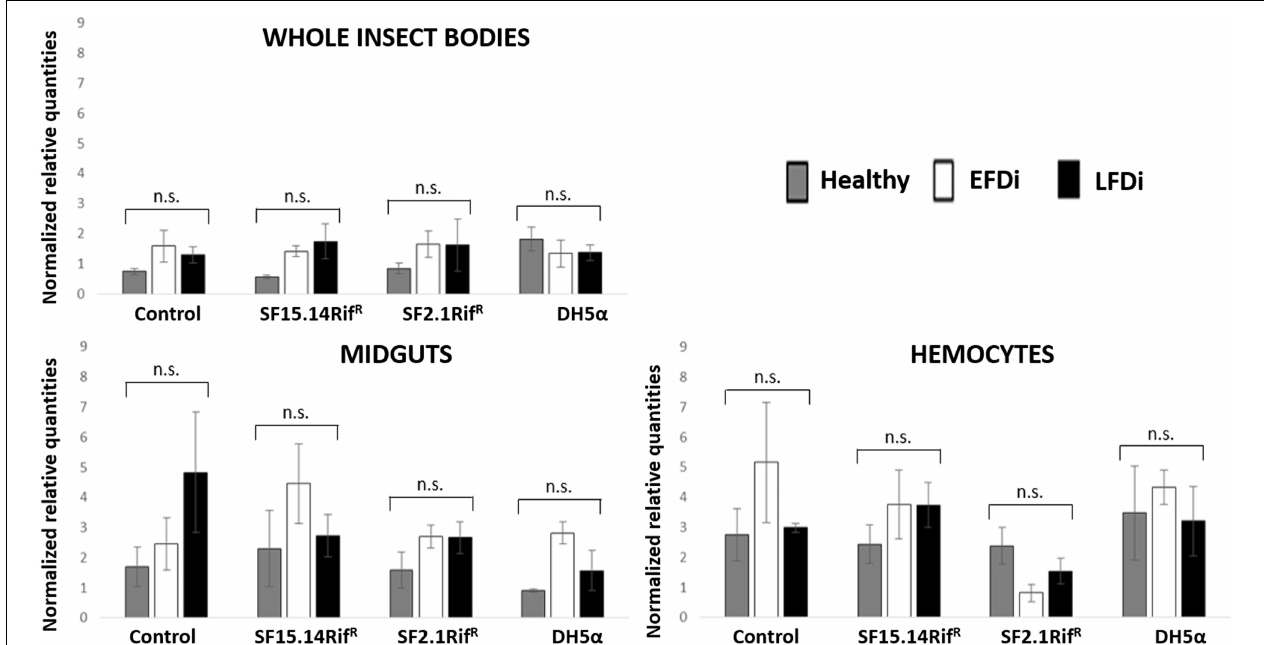
FIGURE 7 | Temporal trend of gene expression for defensin gene. Normalized relative quantities are displayed for whole insect bodies, midgut sections, and cultured hemocytes of insects treated with Asaia SF15.14Rif R , Asaia SF2.1Rif R , and E. coli DH5 α pKan(DsRed), along with the control. Healthy: time 0 of FDp infection; EFDi time 0 + 5 days of FDp infection; LFDi: time 0 + 21 days of FDp infection. DH5 α : E. coli DH5 α pKan(DsRed); n.s., not